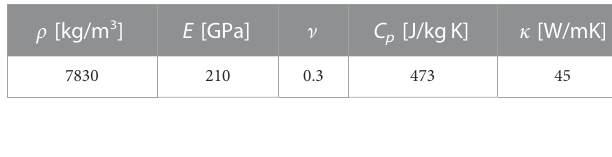
TABLE1Materialparameters forAISI4340steeltakenfrom (Lerochetal.,2018) ρ is the reference bulk density, E Young ’ s modulus, ν the Poisson ratio, C p the speci fi c heat capacity at room temperature, κ the heat conductivity.